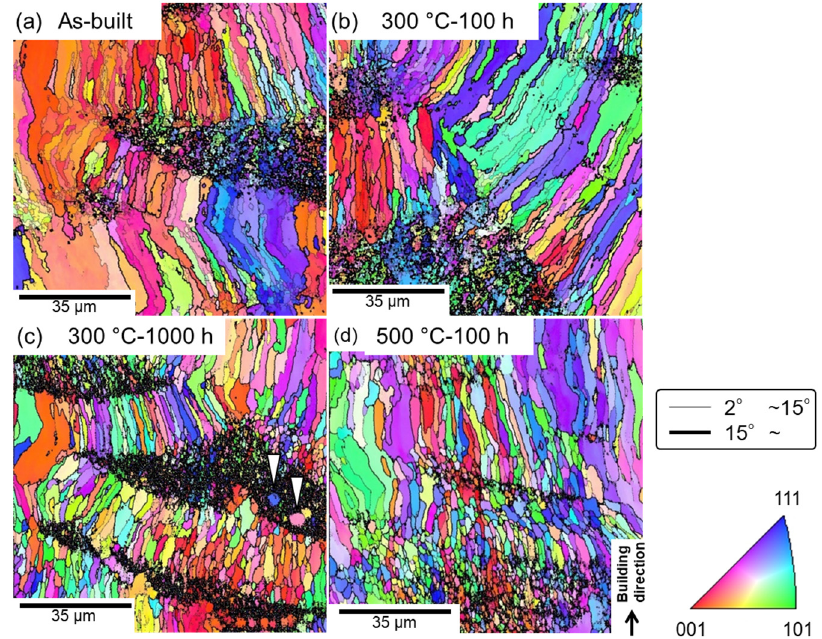
Figure 8. EBSD orientation maps of the fcc-structured α -Al matrix in the ( a ) as-built and ( b – d ) ther- mally exposed samples: ( b ) 300 °C/100 h, ( c ) 300 °C/1000 h, and ( d ) 500 °C/100 h. The fine lines correspond to misorientations ( θ ) of 2° < θ < 15°, whereas the bold lines represent θ > 15°.